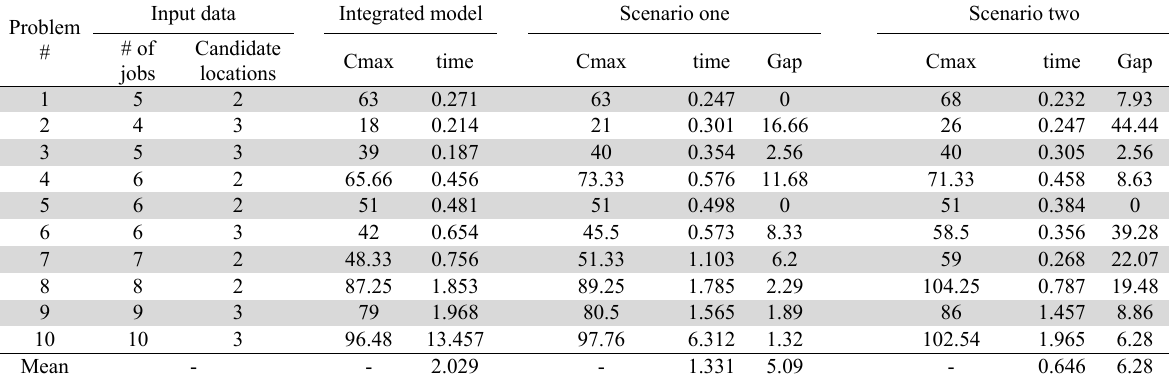
The results of the optimal solution for 10 sample test problems Problem